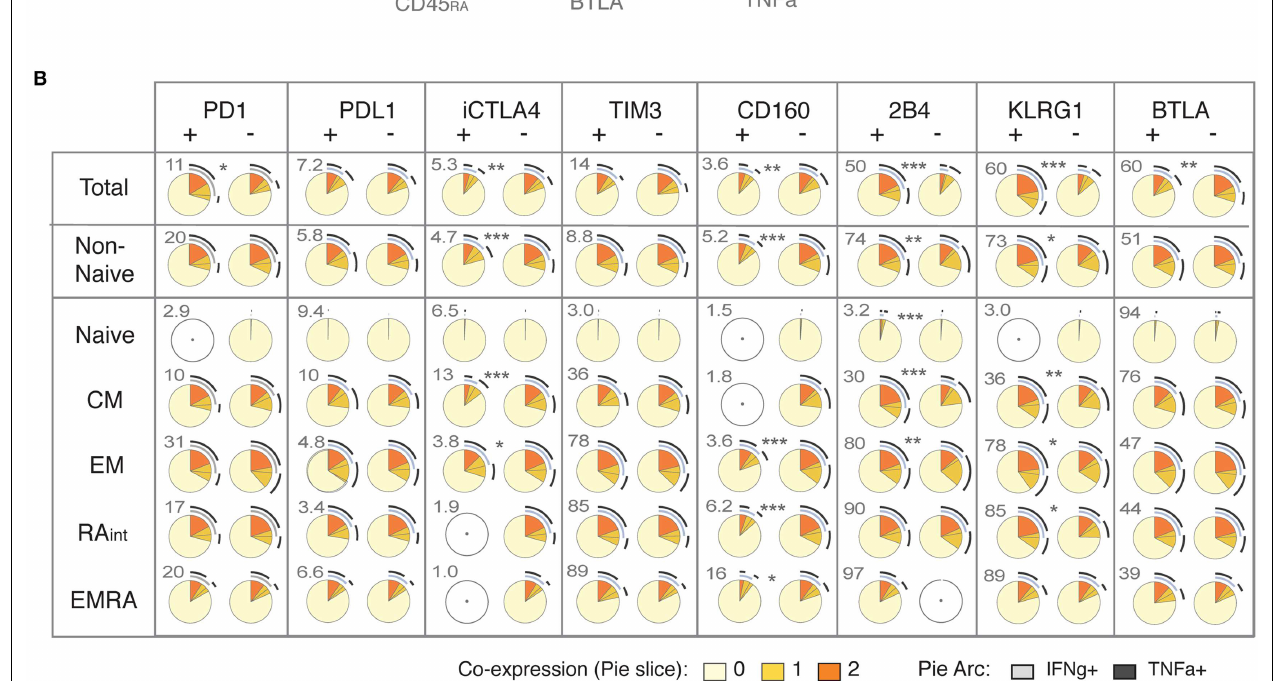
FIGURE 4 | Positive expression of iRs does not necessarily mark lower cytokine production but can rather correlate withT cell differentiation . CD8T cells from healthy donors were stimulated with anti-CD3 and anti-CD28 beads for 4h, similarly as in Figure 2 ( N = 15). (A) . Analysis strategy to compare iR positive versus negative cells, depending on CD8T cell differentiation.Total CD8T cells or each differentiation subset (as indicated) was split into iR positive and iR negative cells, which were subsequently analyzed for cytokine production. (B) Pie charts showing the cytokine production in iR positive or negative cells, considering either in total CD8, in